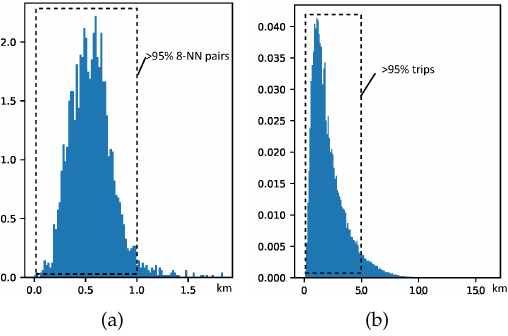
Figure 6. ( a ) The distance distribution of 8 nearest neighbors (8-NN) stations reachable on the road network of each station. ( b ) Trip distance distribution in New York Citi Bike-sharing